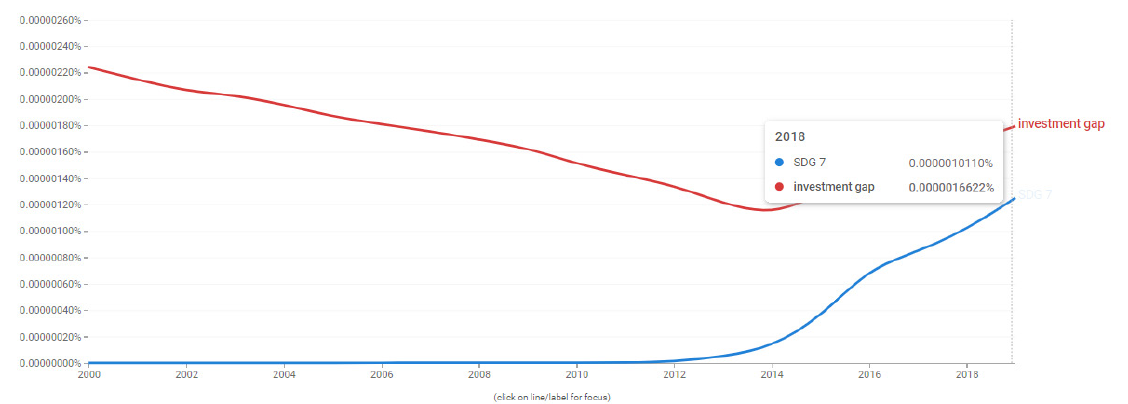
Figure 11. A comparative analysis of SDG 7 and